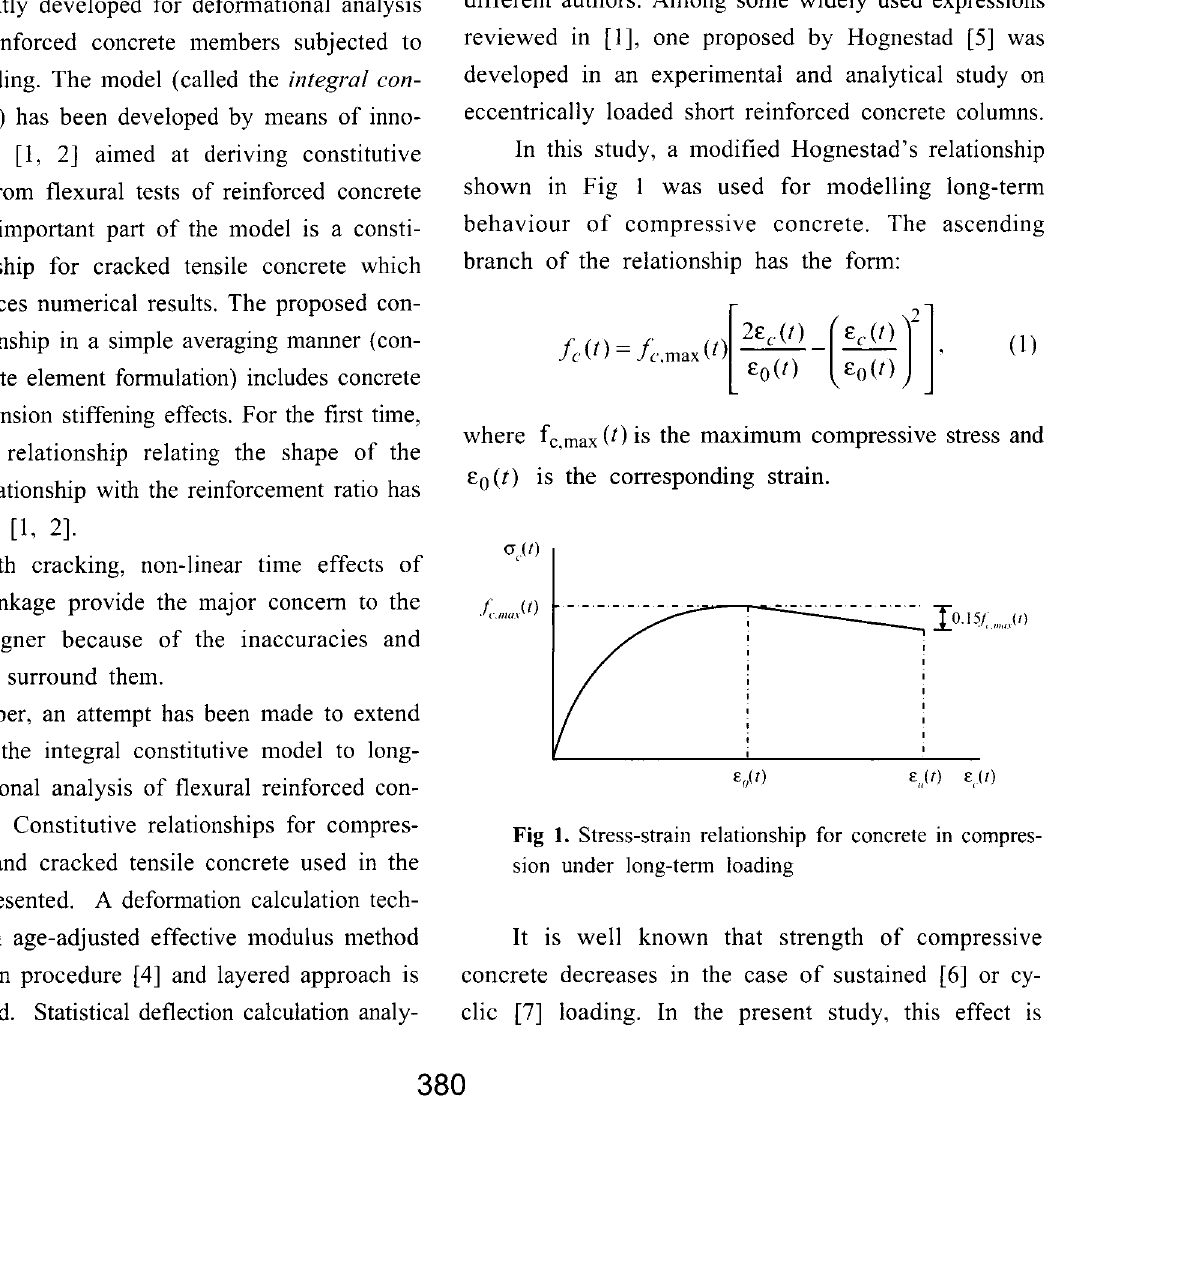
Fig 1. Stress-strain relationship for concrete in compres SIOn under long-term